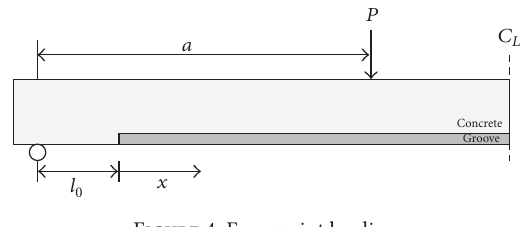
Figure 4: Four-point